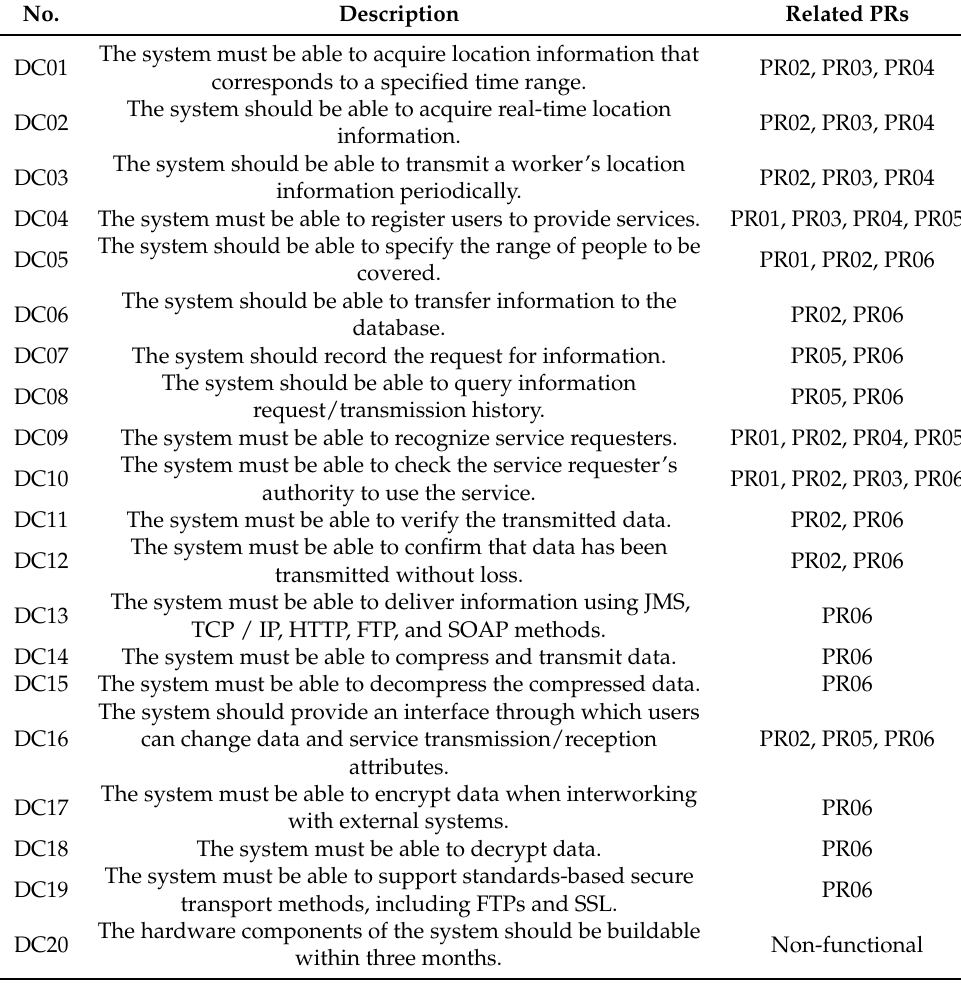
Table 2. Design considerations of the ILMS